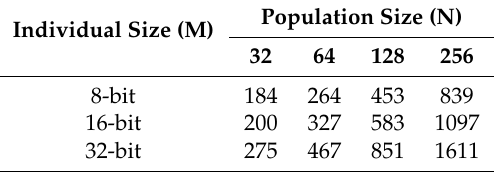
Table 5. Stack memory consumption (in bytes) in the slave node, of a total of 2